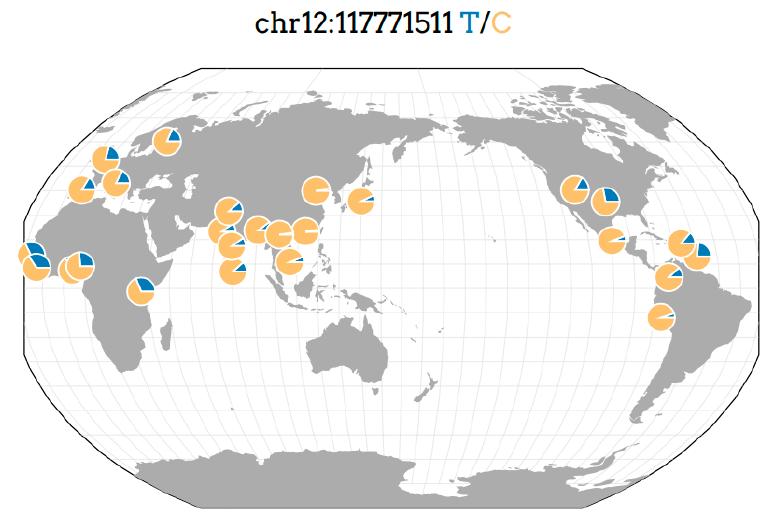
Figure 3. Geography of genetic variant rs3782218 of the NOS1 gene in the world [29].